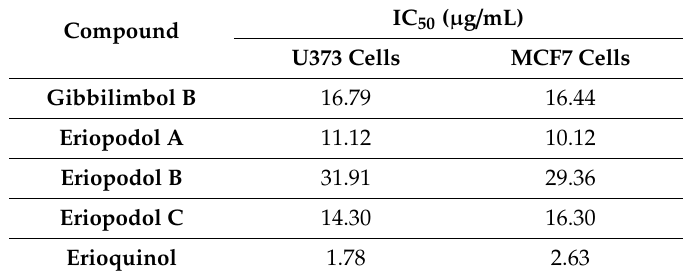
Table 1. Inhibitory e ff ects of Piper genus-derived compounds on human cancer cell viability.